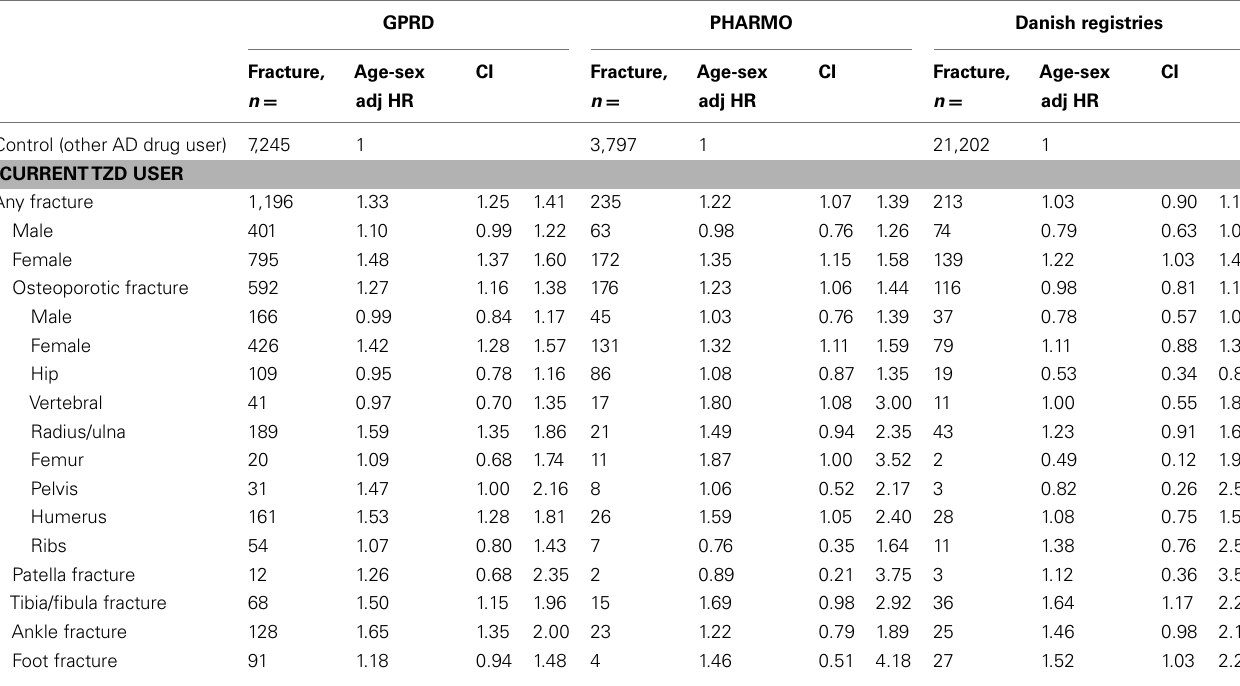
Table 4 | Risk of fracture in currentTZD users compared with other antidiabetic users, by type of fracture and sex.